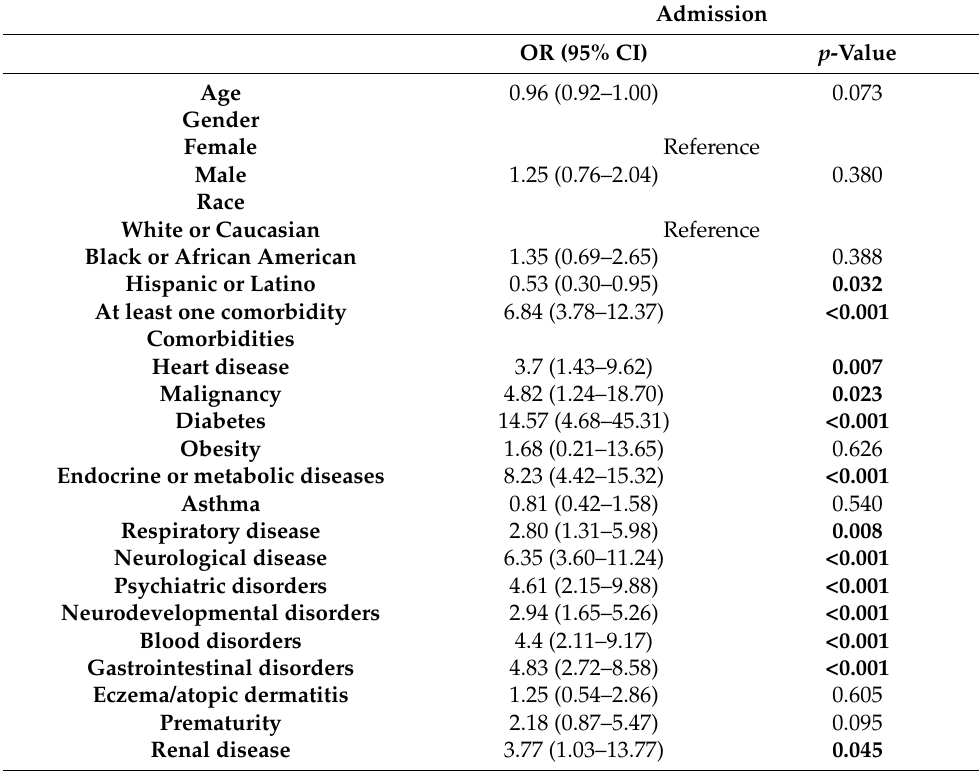
Table 2. Association of demographics and comorbidities with influenza-related hospital admission.